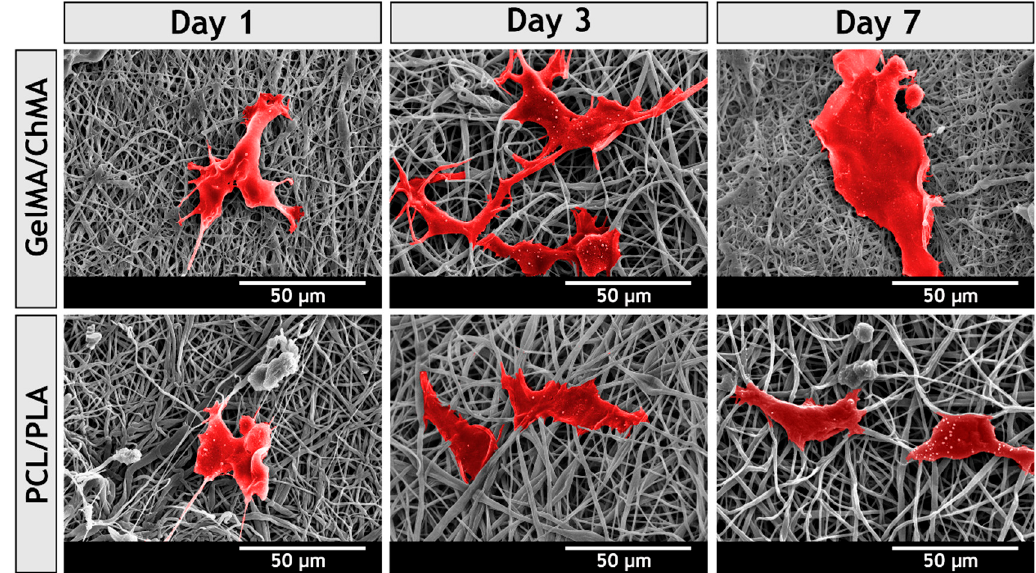
Figure 10. SEM micrographs of NHDF cells morphology adhered on the surface of the different produced membranes, after 1, 3 and 7 days.